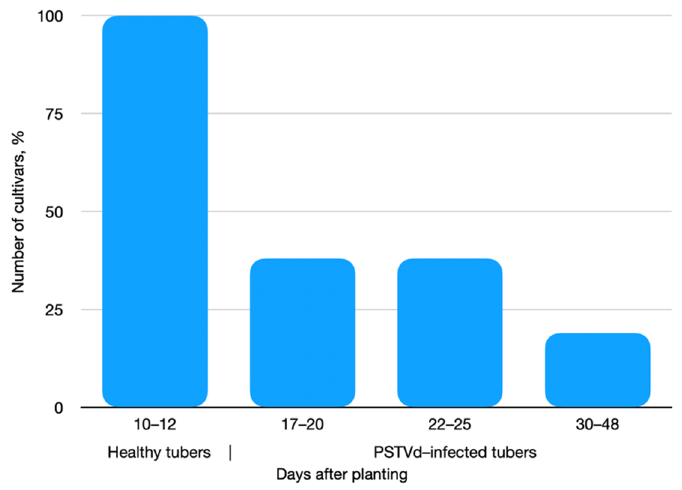
Figure 8. Period of emergence from healthy and PSTVd-infected tubers of second generation. Tubers from PSTVd-infected plants of one cultivar germinated irregularly and de- pended on the viroid strain. For example, sprouts of cv. Bernina appeared 16, 29, 48 (strain FP10-13), and 24 (strain NicTr-3) days after planting. At 48 days after planting, sprouts of cv. Favorit and Sapsan (infested by strain NicTr-3), Nevskiy (VP87), Bernina, and Sorentina (FP10-13) appeared.